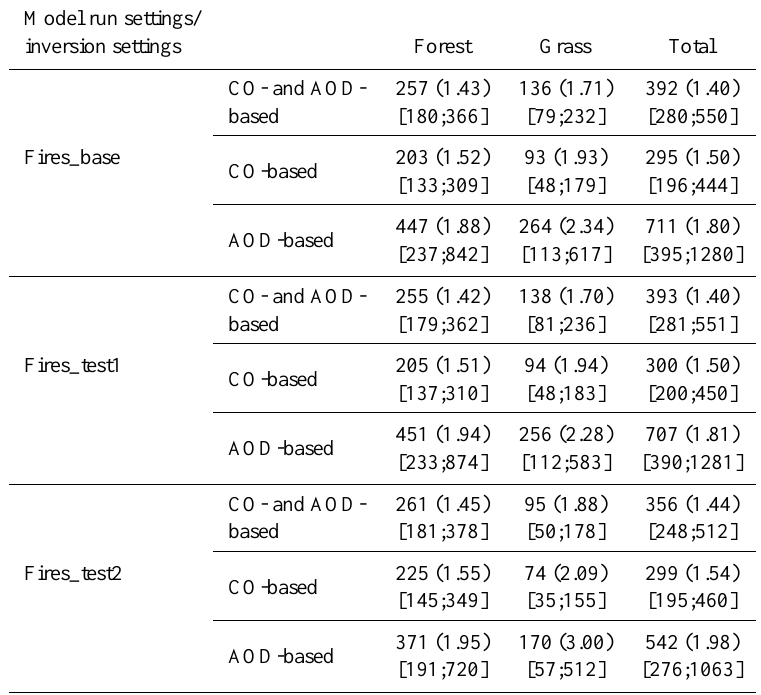
Table 3. Optimal estimates of the CO 2 emissions (TgC) from forest and grass (including agricultural) fires in Siberia in 2012. Different estimates are obtained from outputs of model runs and inversions with different settings. The geometric standard deviations characterizing uncertainties and the corresponding uncertainty ranges are given in round and square brackets,